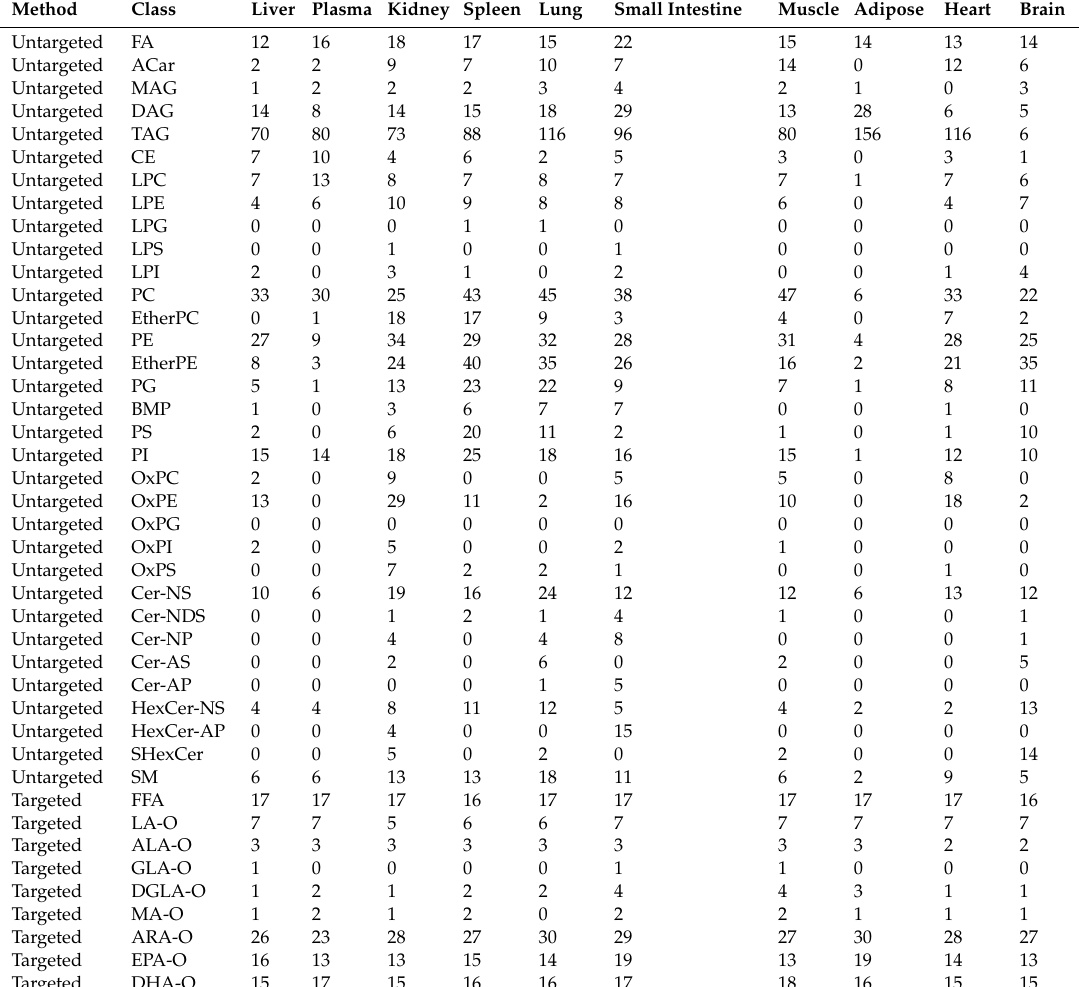
Table 1. Summary of characterized lipids in untargeted and targeted